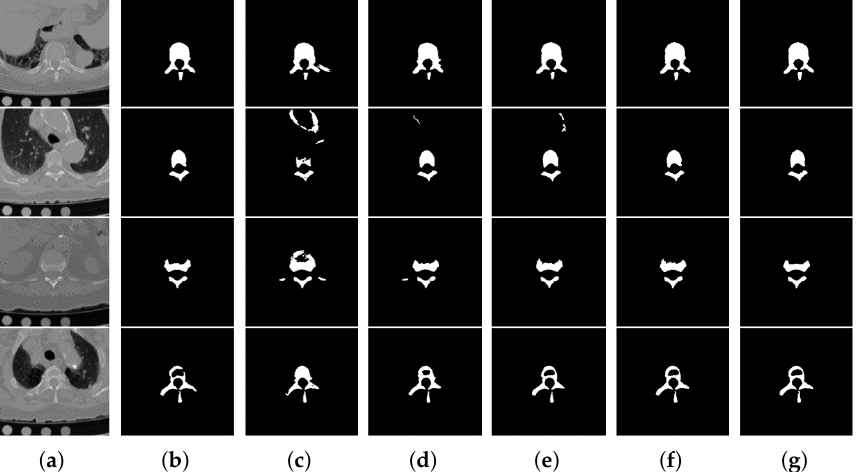
Figure 8. Examples from the ablation study. ( a ) Original image. ( b ) Ground truth. ( c ) Baseline. ( d ) AM only. ( e ) MSC only. ( f ) AM+MSC. ( g ) Overall model (AM + MSC + DS).